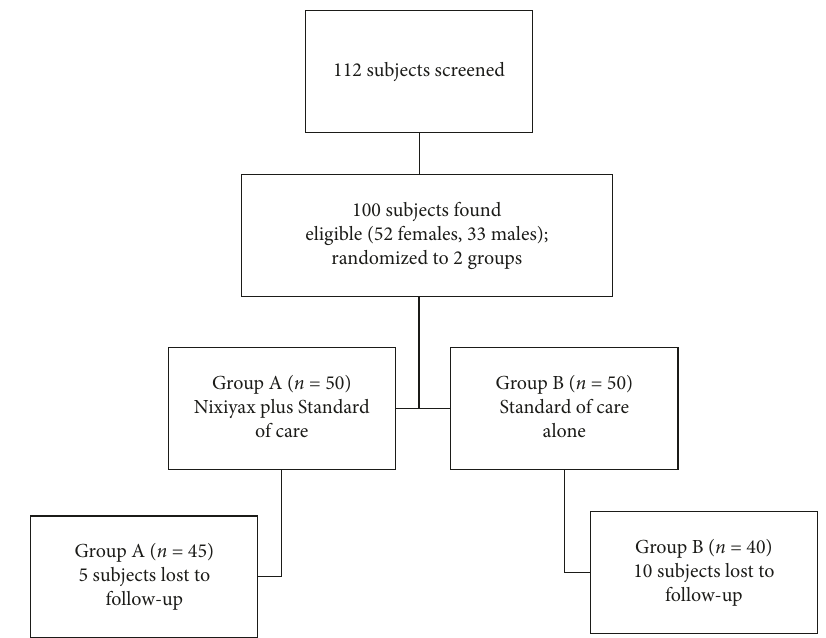
Figure 1: Subject recruitment and